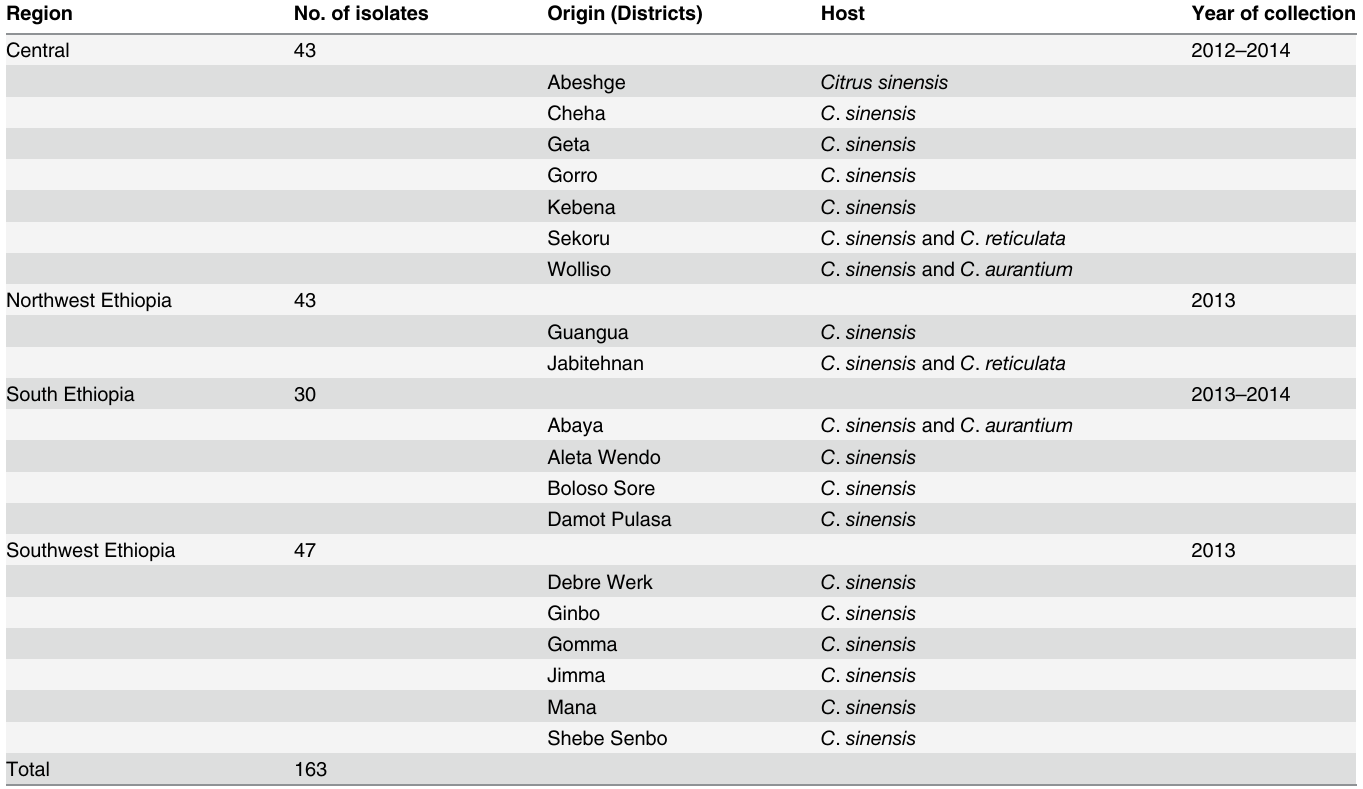
Table 1. Geographic origins of Colletotrichum gloeosporioides populations, the number of isolates represented in each population and their hosts. Region No. of isolates Origin (Districts) Host